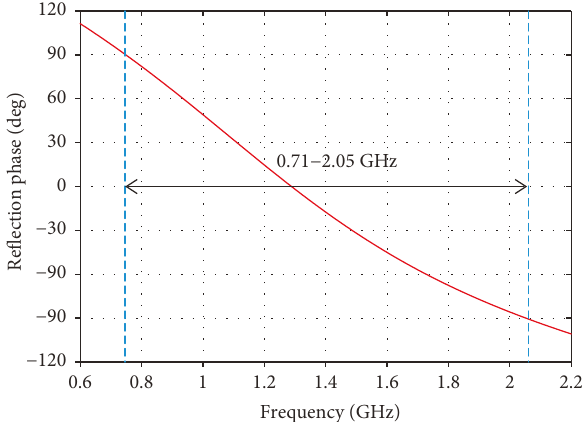
Figure 7: Simulated re fl ection phase of the unit cell of the proposed